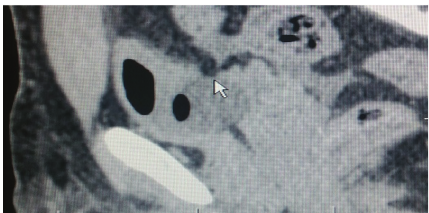
Figure 1: Plain CT scan showing the rent in the bladder marked by the arrow.